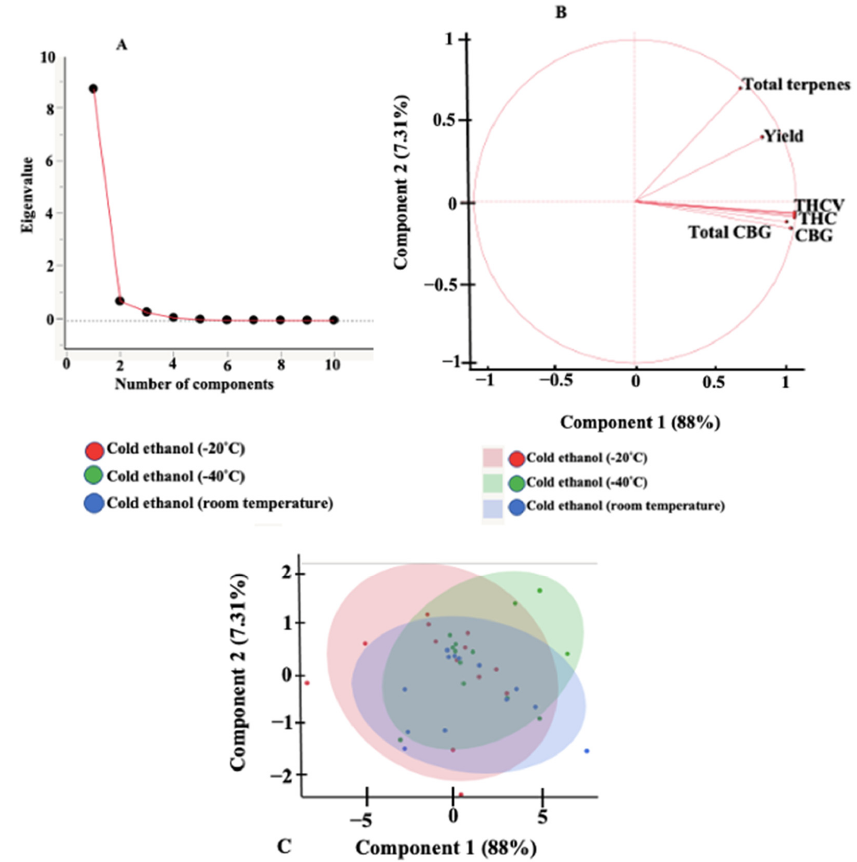
Figure 2. Principal component analysis plots for cold ethanol extraction of cannabis at various tem ‐ peratures: − 20 °C, − 40 °C, and room temperature. Scree plot ( A ), loadings plot ( B ), and scatterplot temperatures: − 20 ◦ C, − 40 ◦ C, and room temperature. Scree plot ( A ), loadings plot ( B ), and ( C ). scatterplot ( C